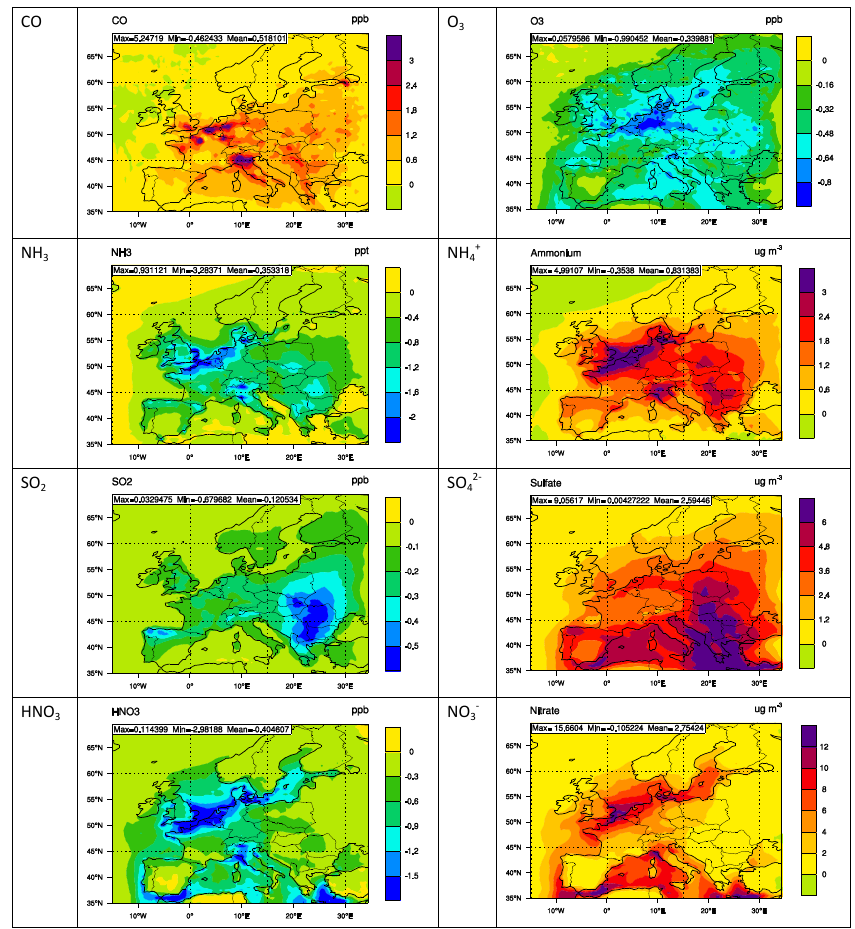
Figure 14. Simulated changes in chemical composition in the presence of aerosol by WRF/Chem-MADRID in July 2001 over D01.